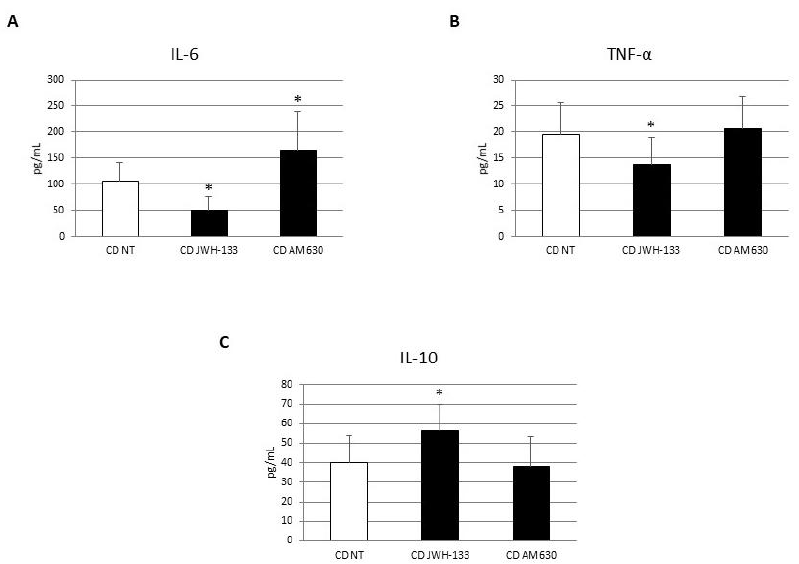
( C ) and pSTAT6 ( D ) protein expressions, determined by Western Blot, loading 15 µ g of total lysate, in macrophages from 5 celiac disease (CD) patients after JWH-133 [100 nM] and AM630 [10 µ M] administration for 48 h. The most representative images are displayed. Image Studio Digits software has been used to detect protein bands. The intensity ratios of immunoblots compared to CTR, considered 1, were quantified after normalizing with respective controls. The histograms represent the relative quantification for CCR7, DMT1, CD206 and pSTAT6 expression, normalized for the housekeeping protein β -Actin, as mean ± SD of independent experiments on each individual sample. A t -test has been used for statistical analysis. * Indicates p ≤ 0.05 compared to NT.